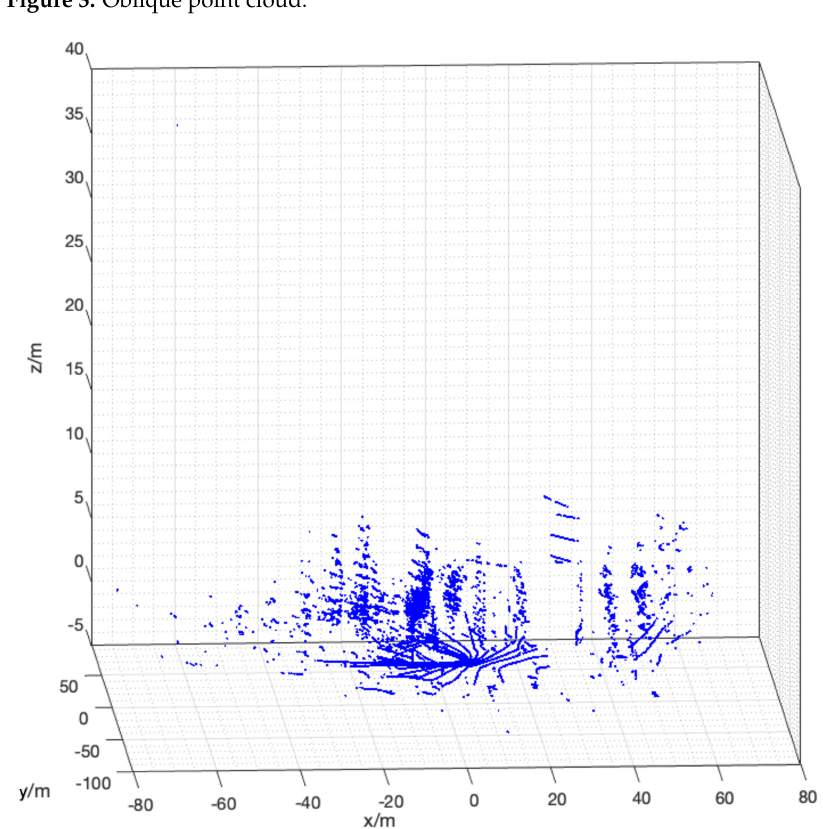
Figure 3. Oblique point cloud.